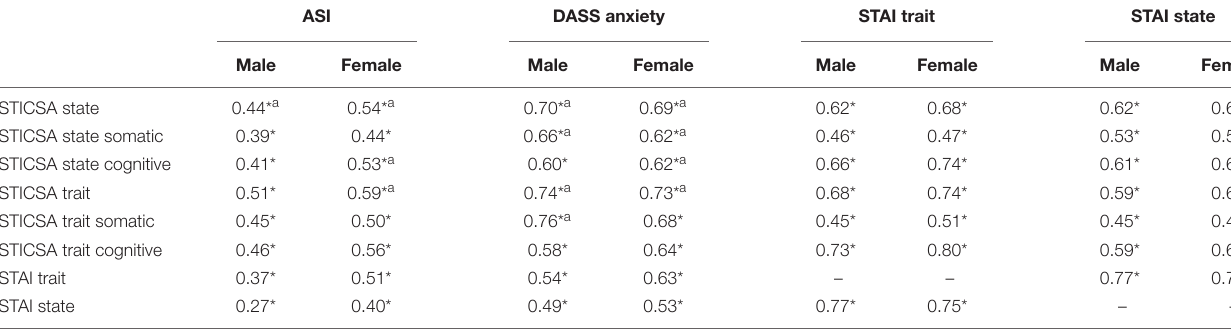
TABLE 5 | Pearson correlations and Steiger’s Z , investigating the concurrent validity of the STICSA and STAI with measures of interest. ASI DASS anxiety STAI trait